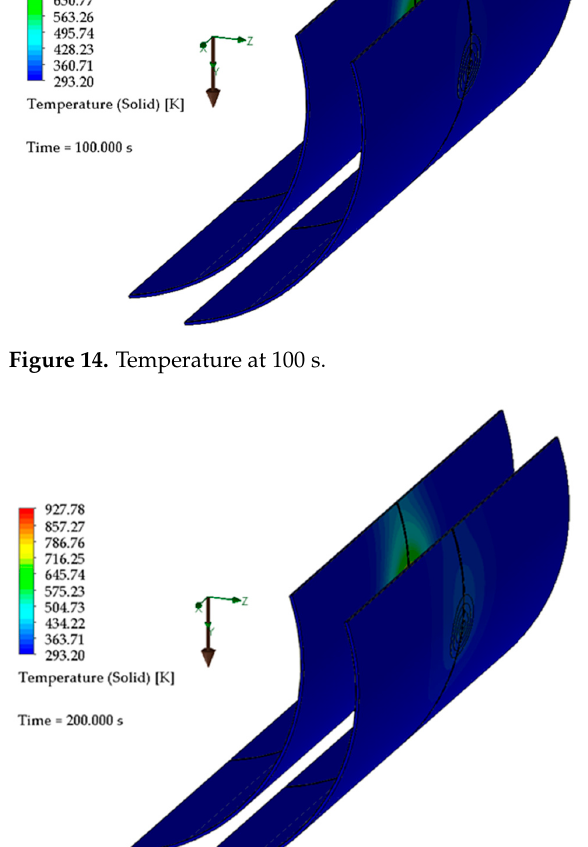
Figure 15. Temperature at 200 s.